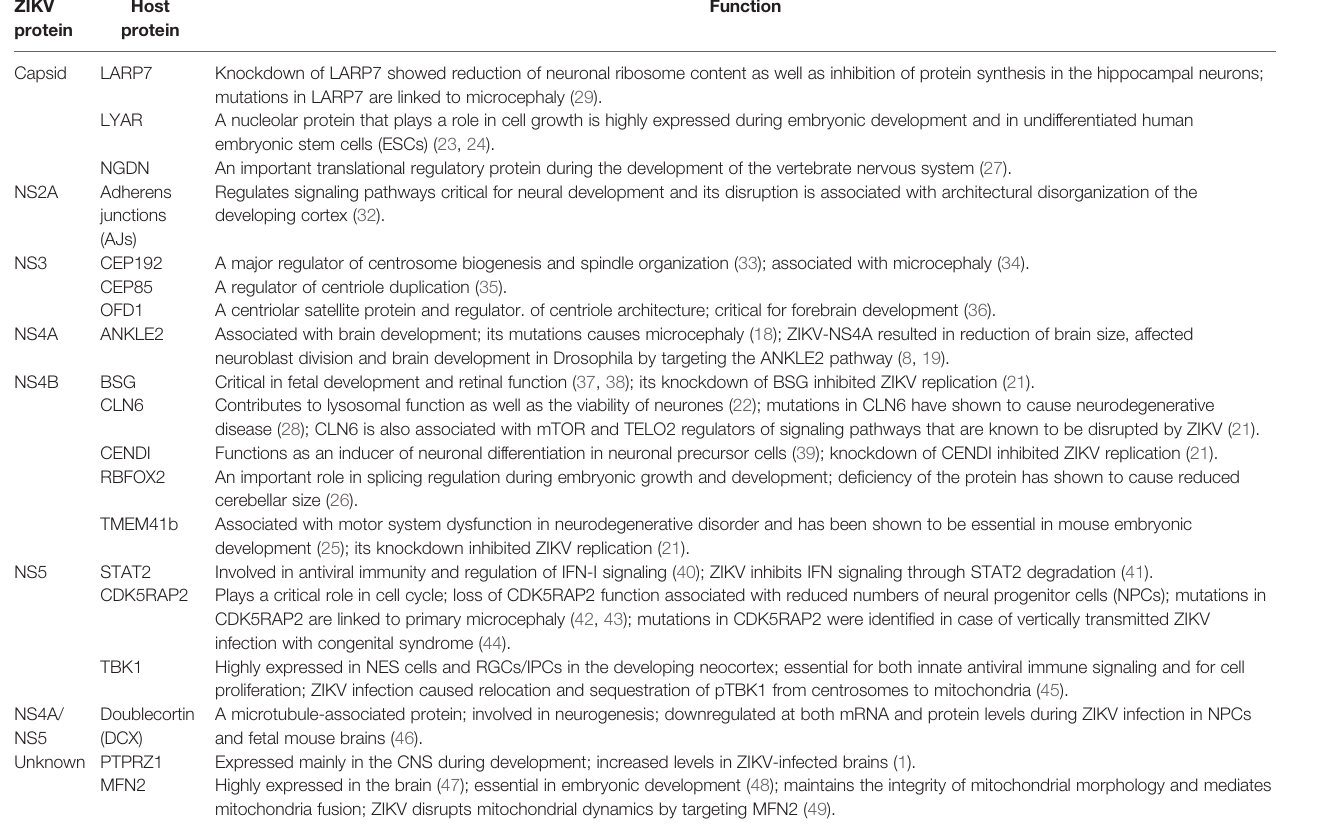
TABLE 1 | Host factors that mediate ZIKV neuropathogenesis. ZIKV Host protein protein